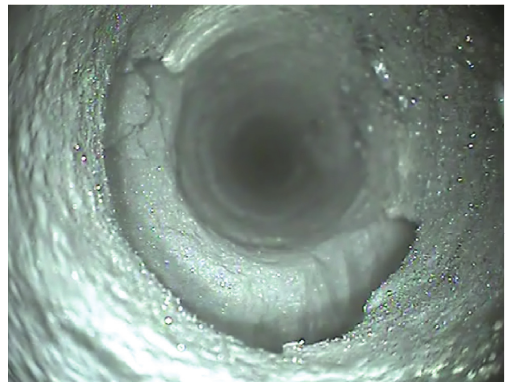
Figure 13: 1# detection of parallel boreholes in face of coal